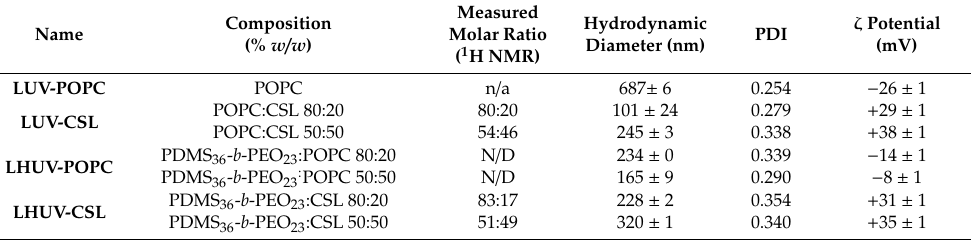
Table 1. Physicochemical properties of large unilamellar vesicles and hybrid vesicles (LUVs